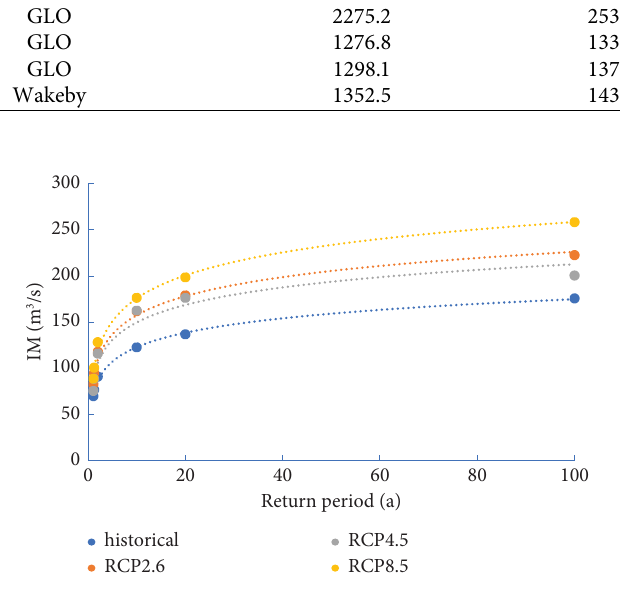
Figure 7: Annual minimum daily runof with diferent return periods.